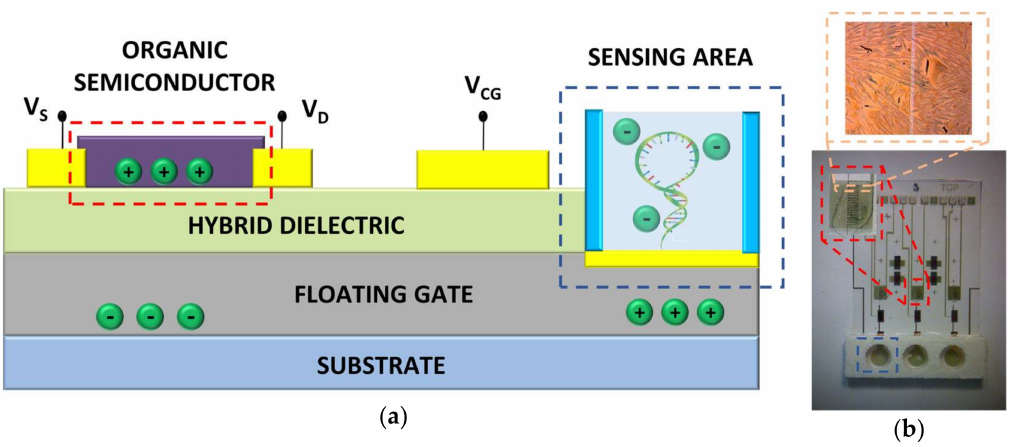
Figure 2. ( a ) Pictorial representation of the sensor’s cross-section. Floating-gate electrodes were fabricated in aluminum and patterned by means of photolithography. A hybrid-dielectric made of a thermally-growth Al 2 O 3 layer and a Parylene C film allows low voltage device operation. Control-gate, source, and drain electrodes and the sensing area are made of gold and patterned by means of photolithography; ( b ) Picture of the device fabricated as described in materials and methods section. The insets show a magnification of the channel